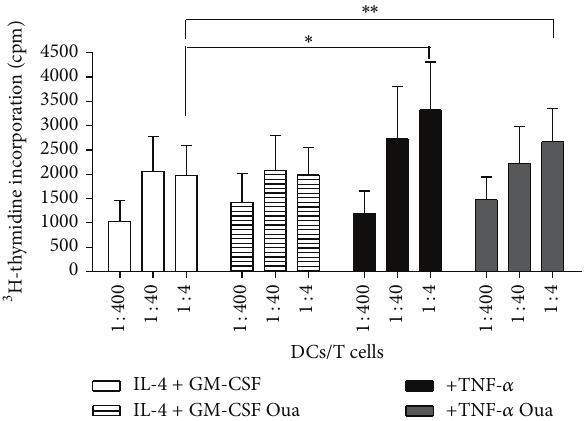
Figure 10: Evaluation of mixed lymphocyte reaction of immature and mature dendritic cells previously incubated with Ouabain. DCs treated with or without 100 nM Oua were cocultured with allogeneic lymphocytes (10 5 cells/well) at indicated cell ratio, for 5 days. Proliferation was assessed in terms of H 3 -thymidine incorporation, added for 6h after the culture period. Data in bars are expressed as mean incorporation ± SEM of five independent experiments in triplicate ( ∗ 𝑃 < 0.05 ; ∗∗ 𝑃 < 0.01